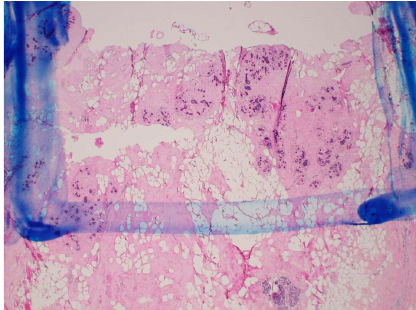
Figure 7. 2 X magnification of histology slide showing the 1.5-mm by 5.0-mm analysis